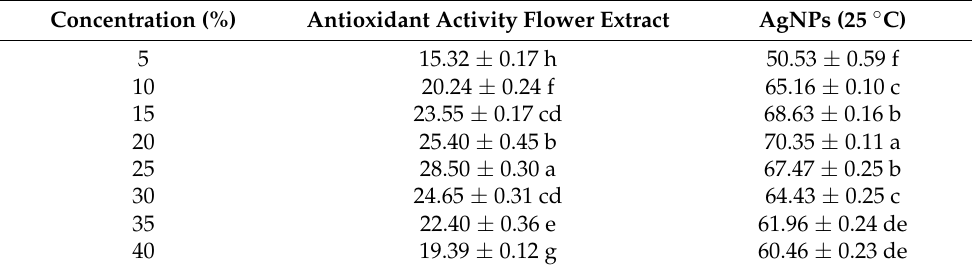
Table 1. Antioxidant Activity of Plant Extract and AgNPs. Concentration